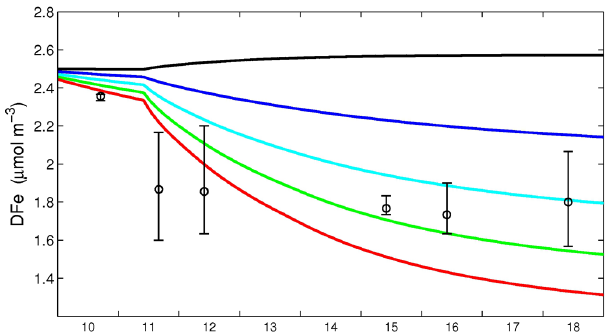
Fig. 9. Sensitivity study with respect to adsorption rate constant ( k sorp ). Depth-averaged DFe is plotted with k sorp = 2 . 5 (black), 2 . 5 × 20 (blue), 2 . 5 × 40 (light blue), 2 . 5 × 60 (green) and 2 . 5 × 80 (red) m 3 kg − 1 d − 1 . Circles are measured DFe concentrations (depth-averaged). Error bars show the total range of measured data.